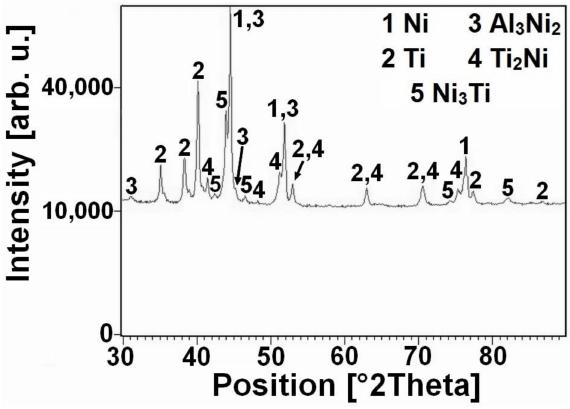
Figure 2. XRD pattern of NiTiAl5 sintered at 610 ◦ C with duration of 20 min and quickly cooled in water.